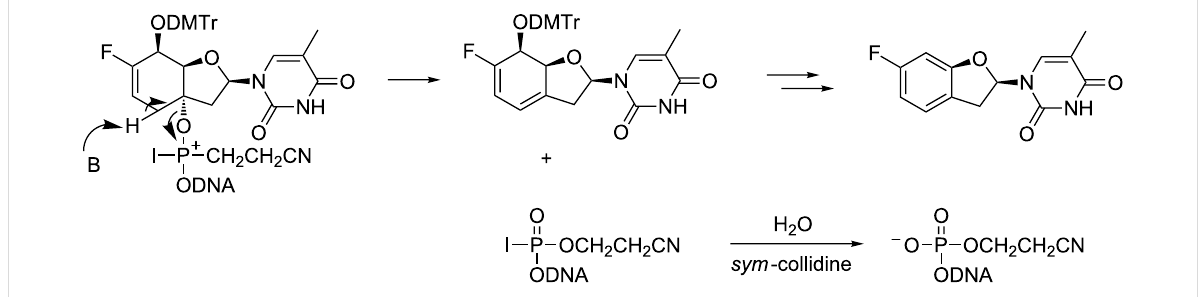
Figure 2: Proposed mechanism for the formation of the 5’-phosphorylated fragments during the oxidation step in the synthesis of ON1 and ON2 .